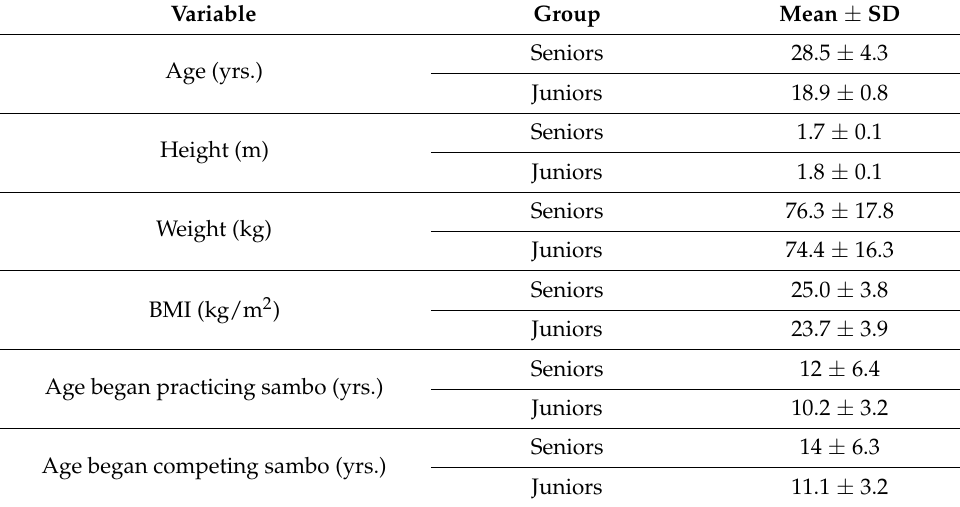
Table 1. Main characteristics of the sambo competitors.